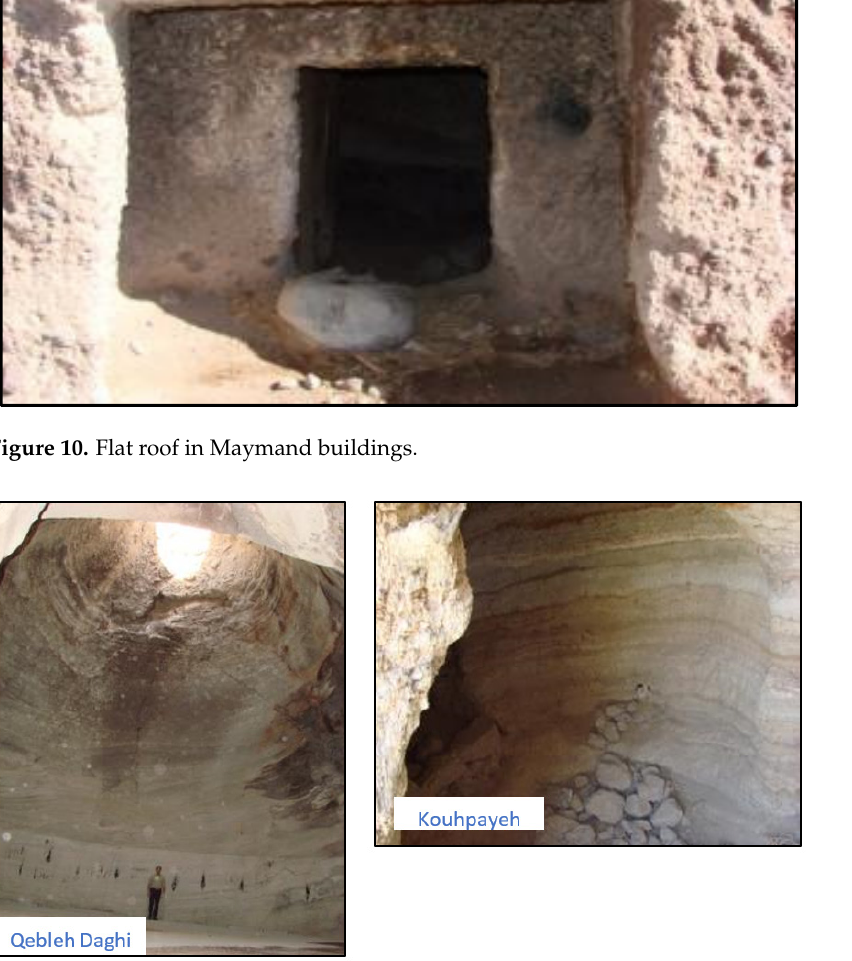
Figure 9. Arched excavation in the form of barrel arch in Koupayeh of Kerman and Bafran of Naein.